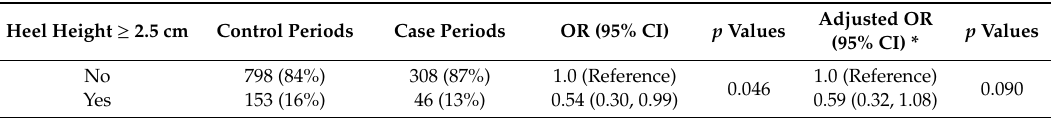
Table 2. Association between wearing shoes with heel height ≥ 2.5 cm (yes vs. no) over the past 24 h and pain exacerbation ( n =